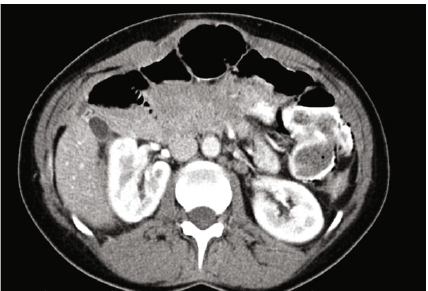
Figure 1: Intra-abdominal desmoid tumour.